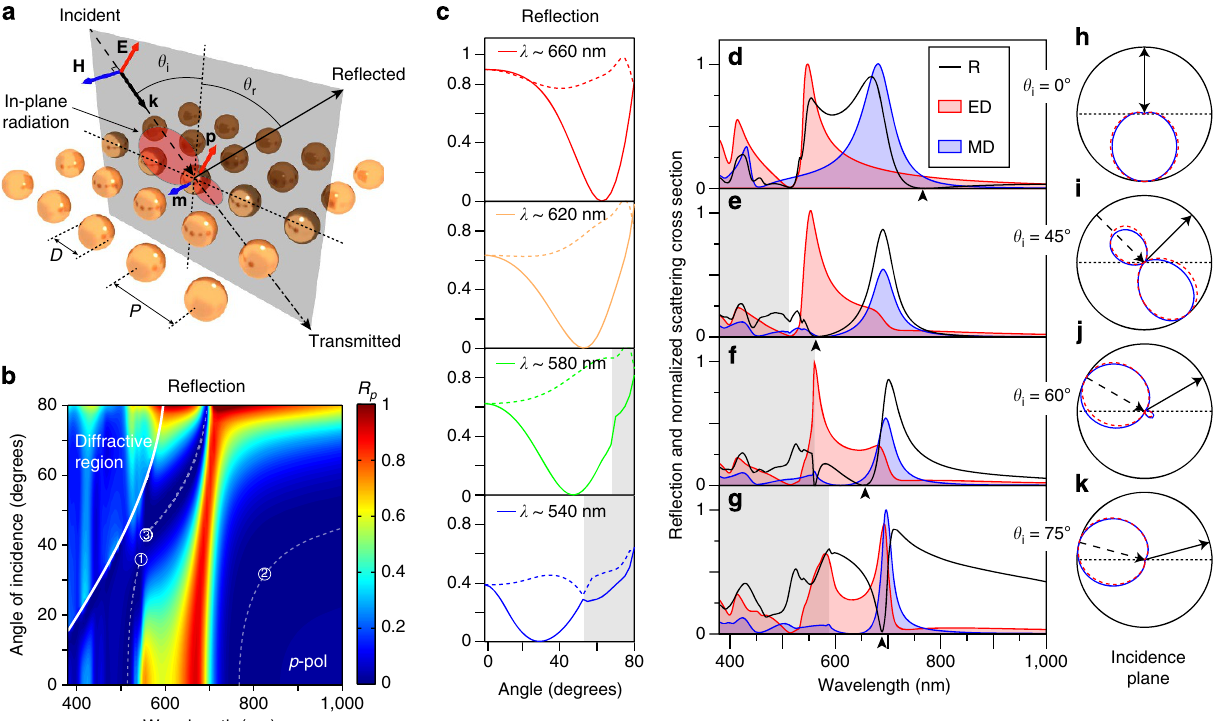
Figure 3 | Simulated optical response of arrays of silicon spheres under p -polarized oblique incidence. ( a ) Scheme of the simulated system. ( b ) Numerically calculated reflection versus wavelength and angle of incidence for a square lattice of silicon spheres with diameter D ¼ 180nm and pitch P ¼ 300nm. The diffractive region is indicated and delimited by a thick, solid, white line. The light-white, dashed lines are guides to the eye to help identifying the low reflectivity regions of interest. ( c ) Reflection versus angle of incidence for selected wavelengths showing the strong dependence of Brewster’s angle on wavelength as well as the possibility of achieving values below 45 (cid:2) . Solid lines correspond to p -polarization while dashed lines are the corresponding curves for s -polarization. Grey-shaded areas mark the spectral regions affected by diffraction. ( d , g ) Reflection (black curve), together with electric dipole (red curve and corresponding shaded area) and magnetic dipole (blue curve and corresponding shaded area) contributions to scattering (normalized to their common maximum) as a function of wavelength for the cases of normal incidence and oblique incidence with y i ¼ 45, 60 and 70 (cid:2) , respectively. Diffractive region is indicated by a shaded grey area. ( h – k ) Radiation patterns in the plane of incidence numerically computed via Stratton–Chu formulas (blue solid curve) and from the induced electric and magnetic dipoles only (red dashed curve) at the wavelength of minimum reflection (arrow heads in d – g respectively). Incidence and reflection direction are shown by (blue solid lines). Also shown (red dashed lines) are the patterns radiated by the pair of electric p and magnetic m dipoles given by the multipole decomposition, computed through equation (1).